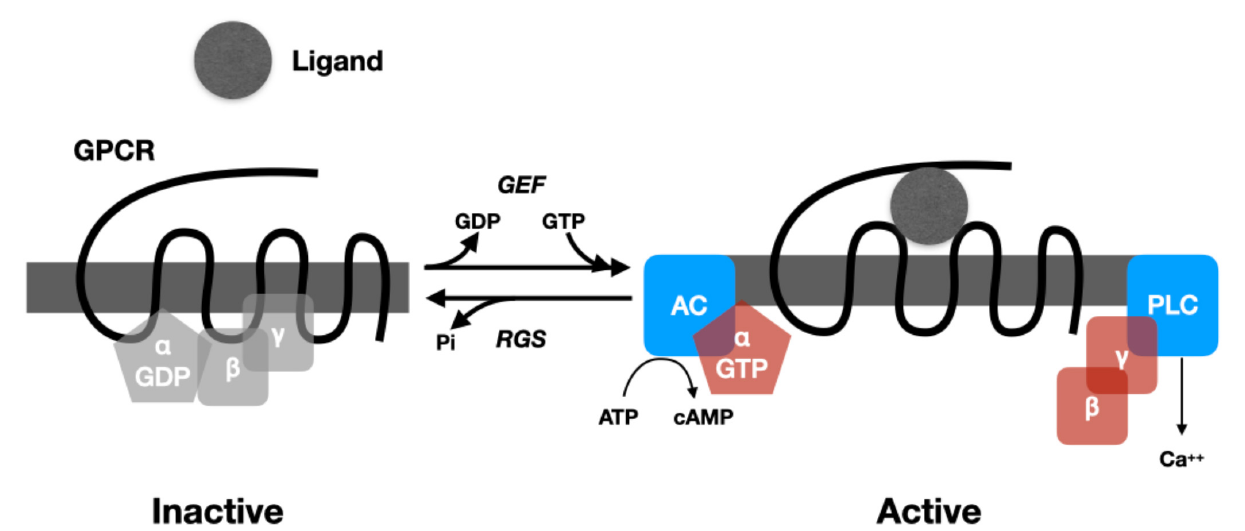
FIGURE 1 | Cartoon representing the operation of a prototypical G-Protein Coupled Receptor. When no ligand is present, G α binds a GDP and the G βγ subunits. When ligand is bound, a GEF (guanine nucleotide exchange factor) promotes exchange of GTP for GDP, causing the subunits of the G-protein to dissociate. G α binds to adenyl cyclase (AC), which then catalyzes cAMP from ATP. G βγ binds phospholipase C, increasing Ca 2 + . Regulator of G-protein signaling (RGS) proteins regulate the hydrolysis of GTP, which returns the G-protein to an inactive state.